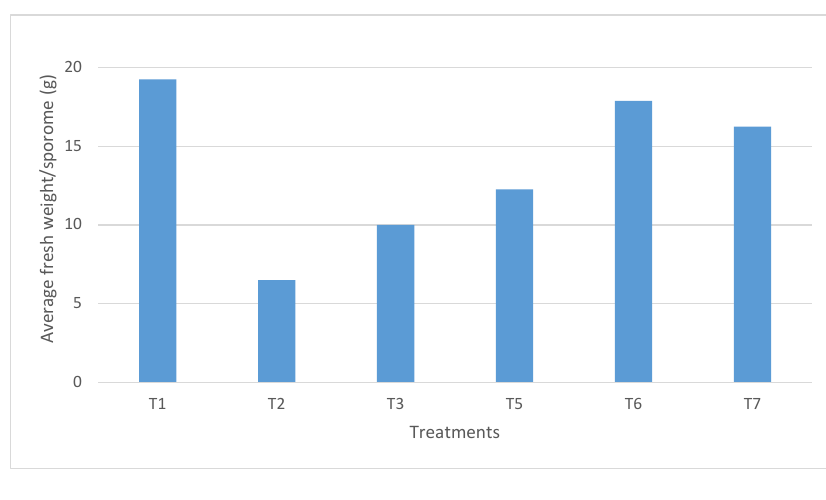
Figure 6 Average fresh weight (g) of sporomes grown on different substrates.